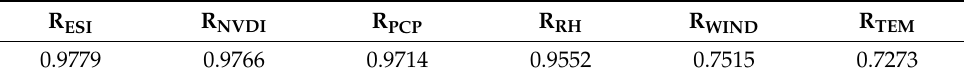
Table 3. Connectivity between related factors and soil conservation